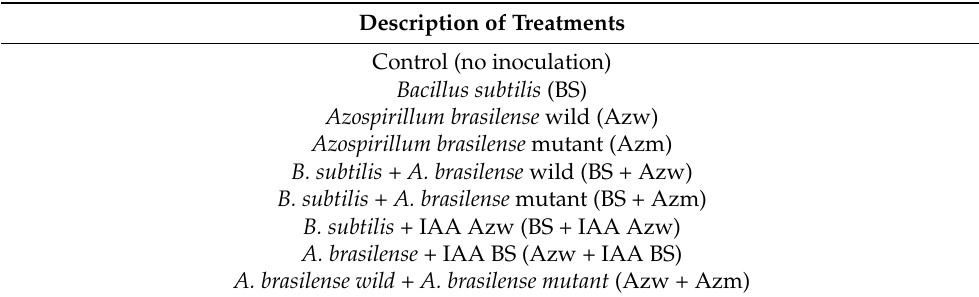
Table 1. Description of treatments in the greenhouse with tomato genotypes Micro-Tom, diageotropic ( dgt ) and Entire